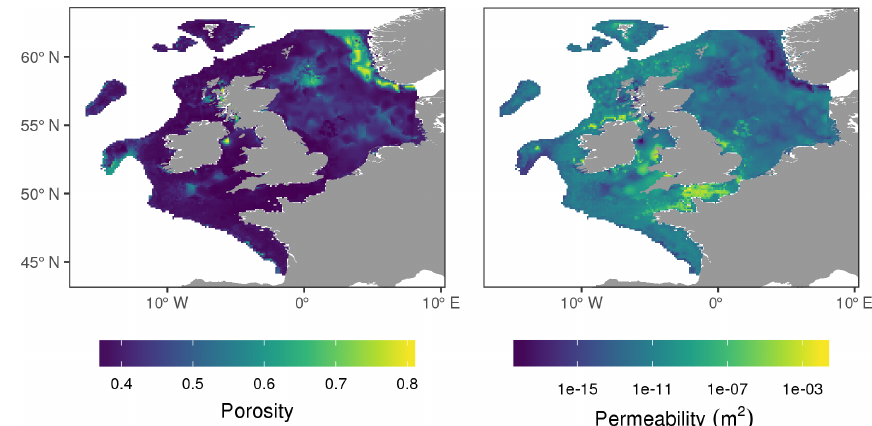
Figure 8. Maps of porosity and permeability. The relationship between porosity and permeability and median grain size was estimated using published field data. We then predicted porosity and permeability using the synthetic map of median grain size.